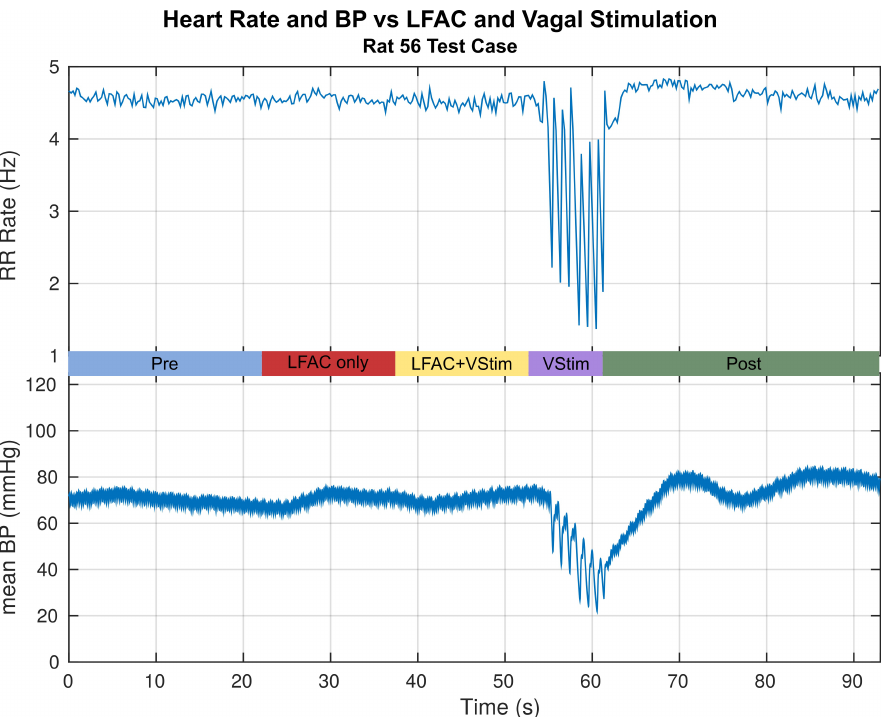
Figure 3. Effects of the typical test sequence on the RR rate of the QRS complex and mean arterial BP. The RR rate for this example is for the data presented in Figure 2. The HR and the BP show no change during LFACb and LFACb+Vagal Stimulation. This suggests that LFACb by itself does not activate fibers, and blocks the descending volley that elicits bradycardia and its accompaniment, hypotension. © 2019 IEEE. Reprinted, with permission, from